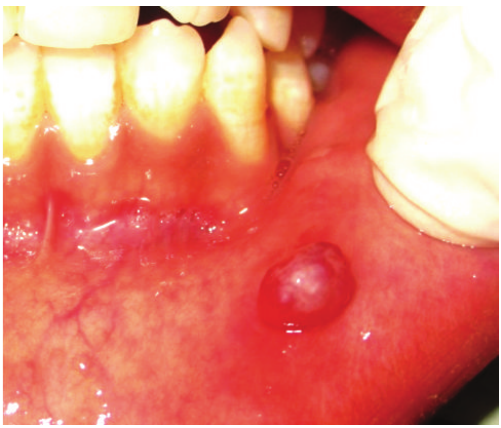
Figure 1: Solitary, well-defined and oval-shaped, nodular exophytic growth on the left half of the lower labial mucosa.